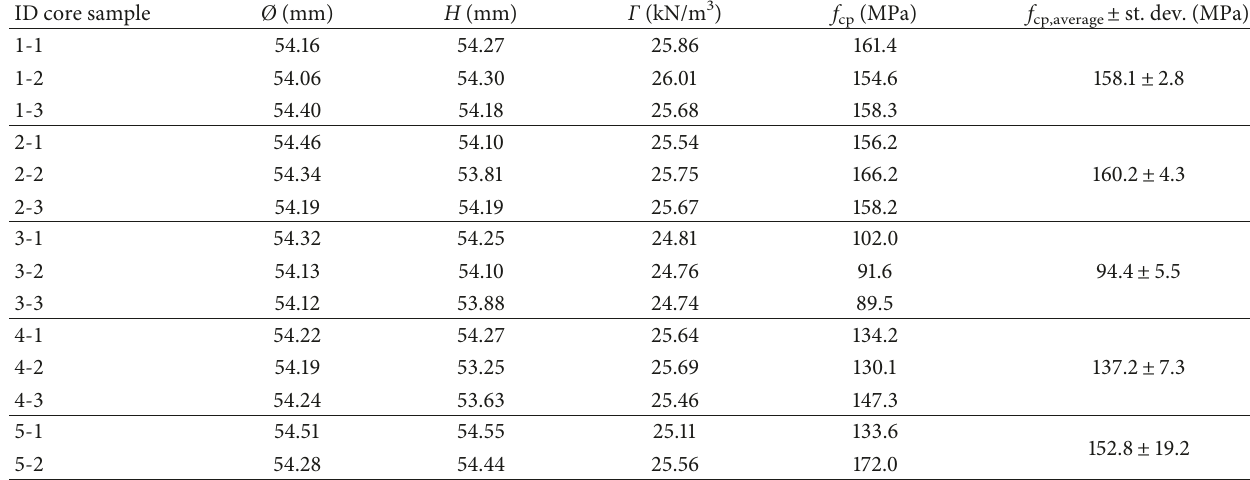
Table 1: ID core sample: identification code.